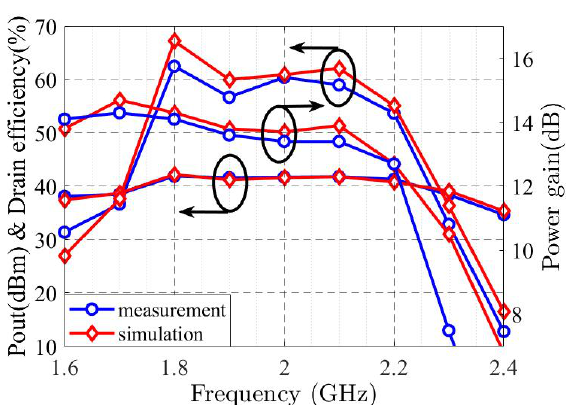
Figure 7. One-tone CW simulated and measured output power, drain efficiency, and power gain at 3 dB gain compression.